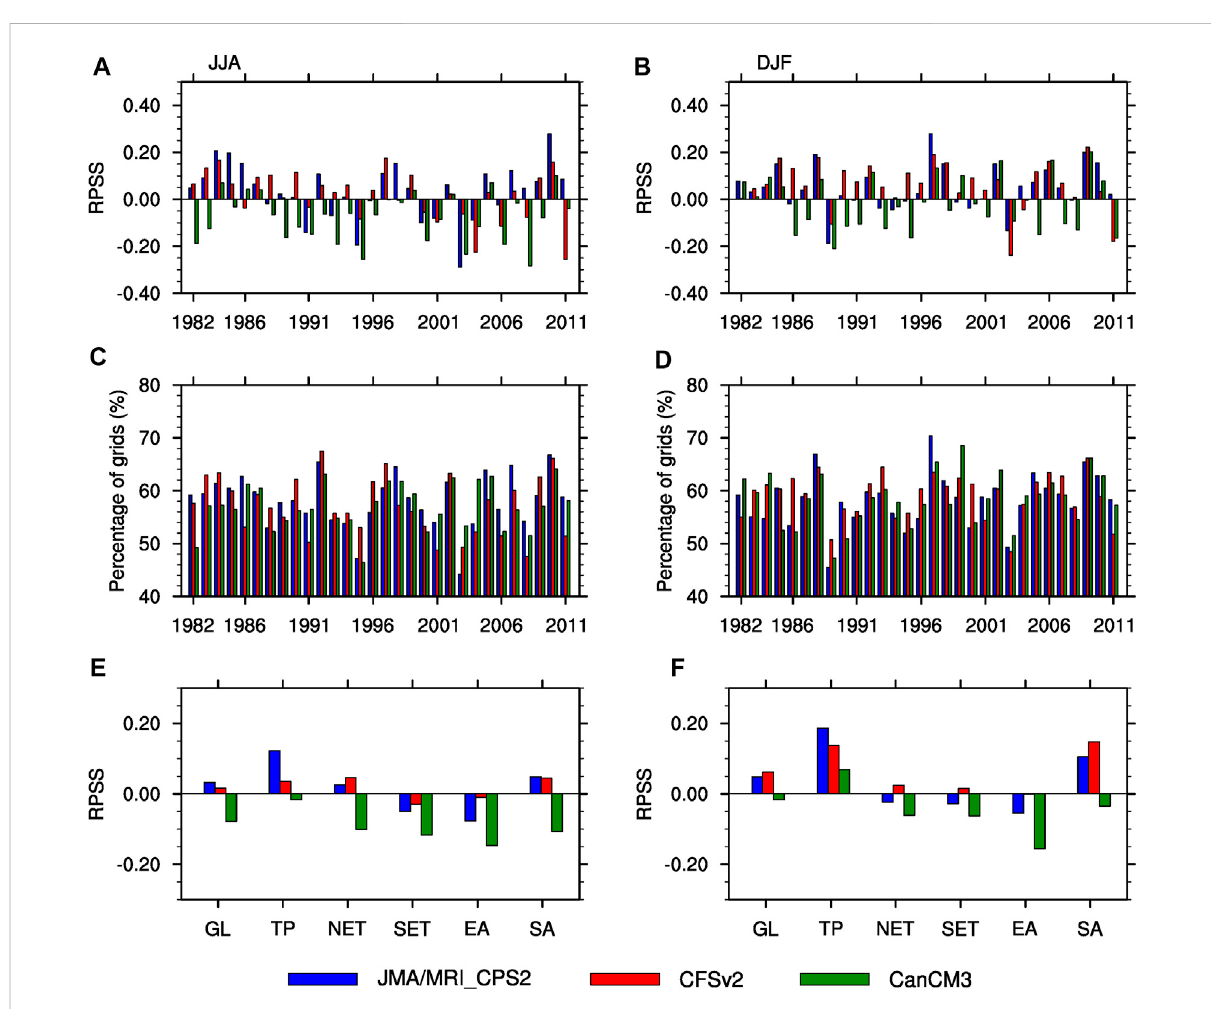
FIGURE 4 Time series of the global-averaged RPSS (A,B) ;and the percentage of grid cells where the RPSS is > 0 out of the global grid cells (C,D) ; thearea- averagedRPSSindifferentregions (E,F) forJMA/MRI-CPS2,CFSv2andCanCM3oftemperatureinJJA(leftpanel)andDJF(rightpanel)seasonforthe period 1982 –